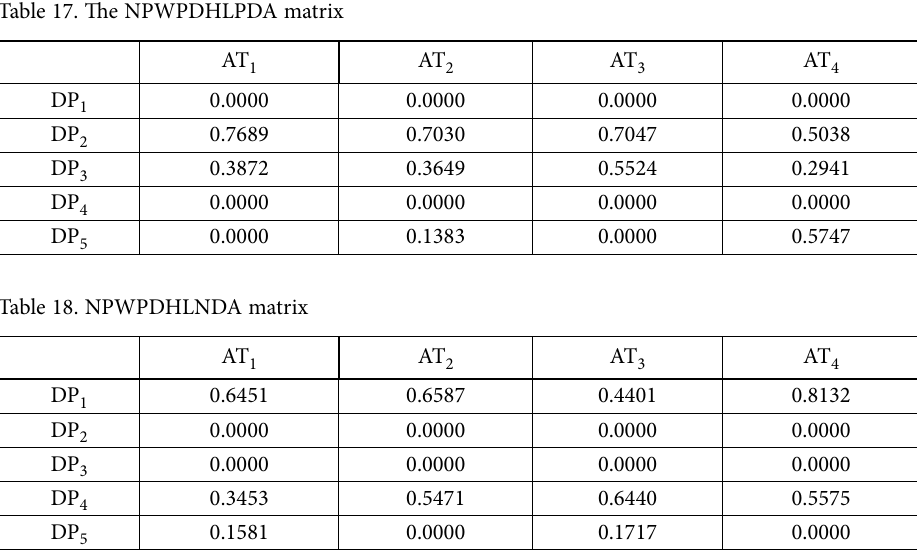
Table 16. NPWAVPDHL for all attributes PDHLBBA ( ) ( AT 1 > − < > − < > AT 2 > AT 3 − > − < > ( AT 4 − > < >